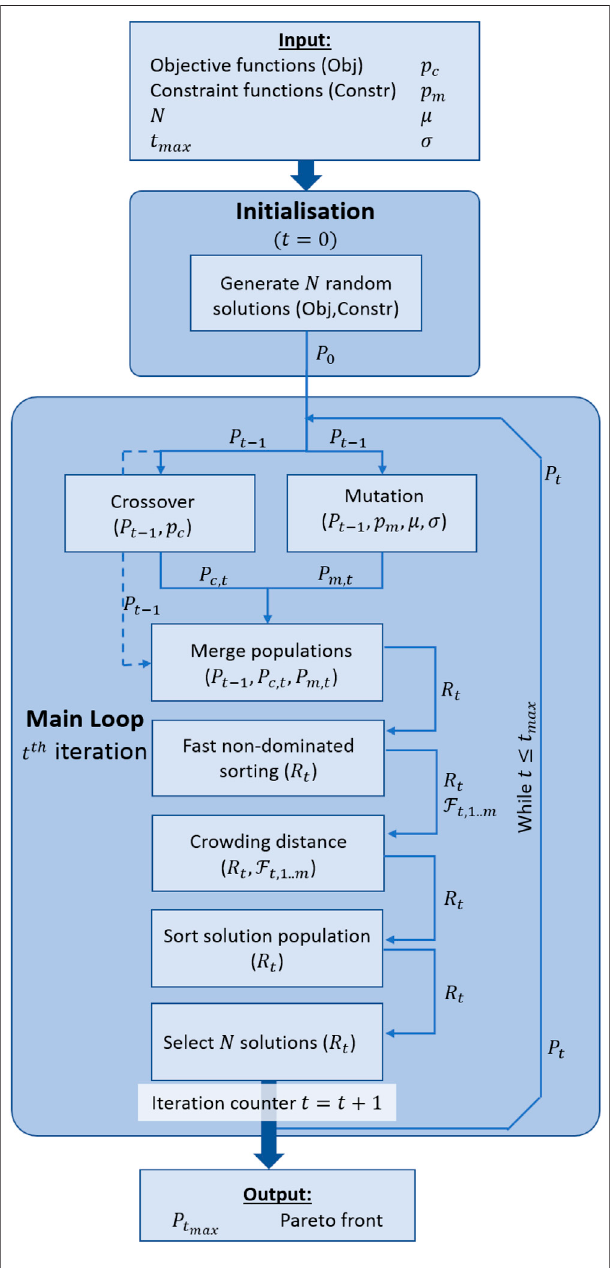
FIGURE 2 | Flow sheet of the NSGA-II